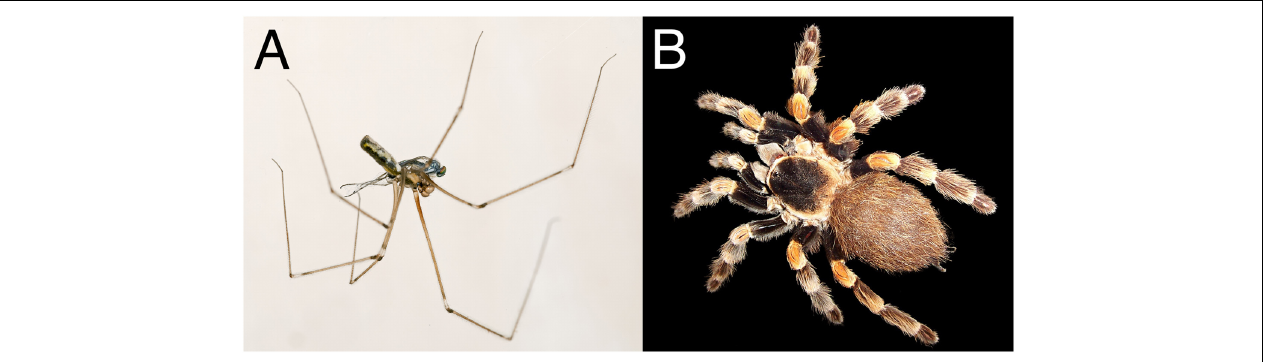
FIGURE 2 | Comparison of the body geometries of Pholcus phalangioides (A) and Brachypelma smithi (B) . Open source images: A—Filename “Pholcus phalangiodes MHNT male. jpg,” courtesy of Didier Descouens, License CC BY-SA 4.0, B—Filename “Brachypelma edit. jpg,” courtesy of user “Fir0002,” License CC BY-SA